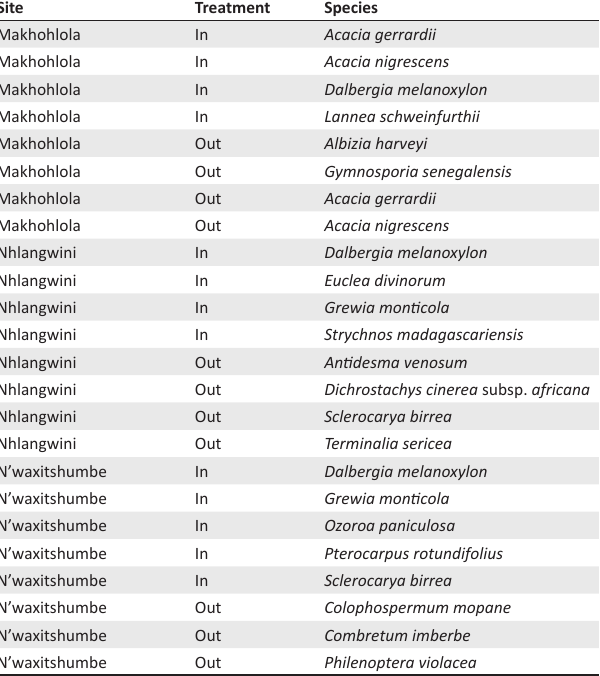
TABLE 2: Dominant woody species accounting for > 80 % of standing biomass for inside and outside treatments at the three Kruger National Park exclosures.